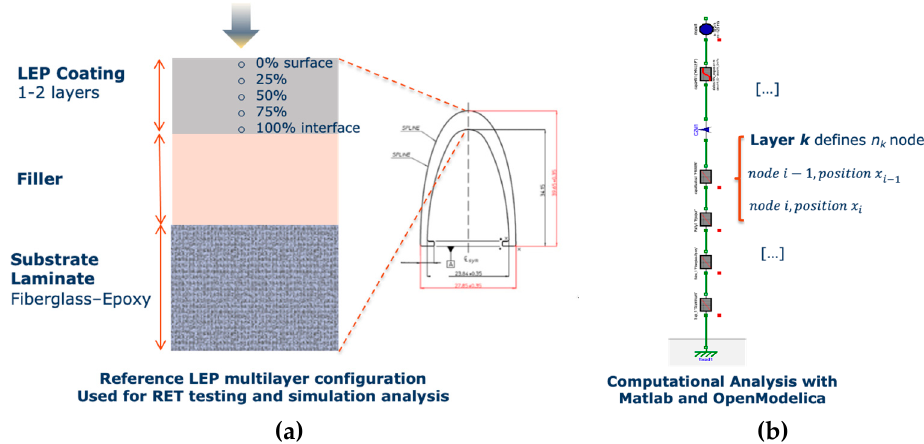
Figure 13. ( a ) Reference multilayer configuration for RET coupons. Liquid droplet and each material layer are defined by the input mechanical parameters of Table 1; ( b ) corresponding numerical configuration outline implemented in OpenModelica.